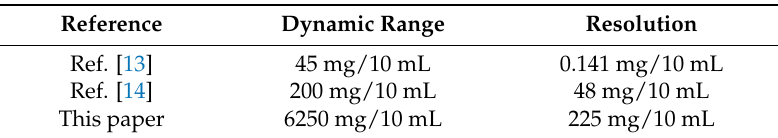
Figure 7. Calibration plot when solutions of glucose-water were considered. Table 2. Comparison of Dynamic Ranges and Resolutions with other published works when glucose was considered.